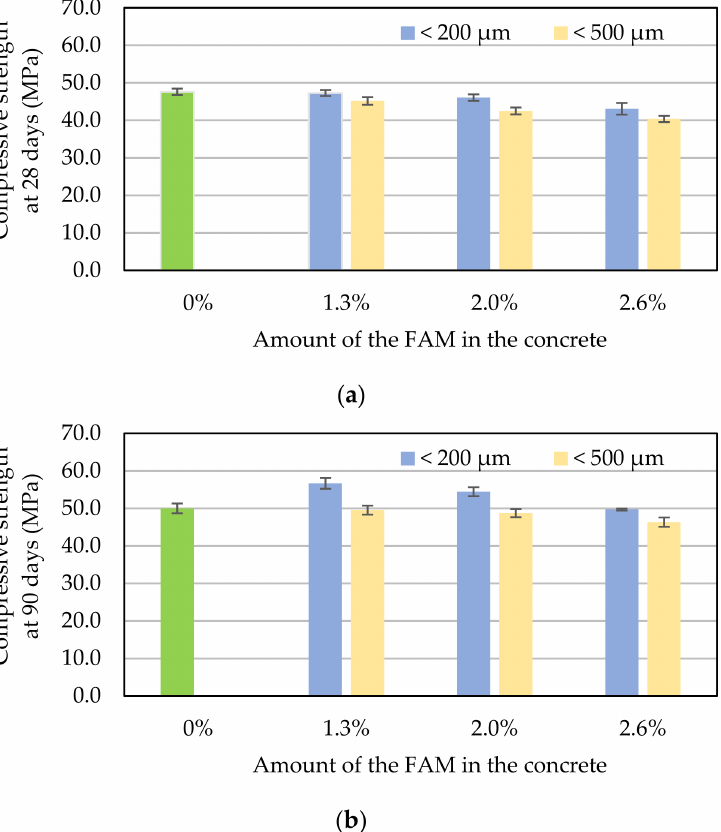
Figure 3. Average compressive strength of concrete without and with different content of FAMs: ( a ) at 28 days, ( b ) and at 90